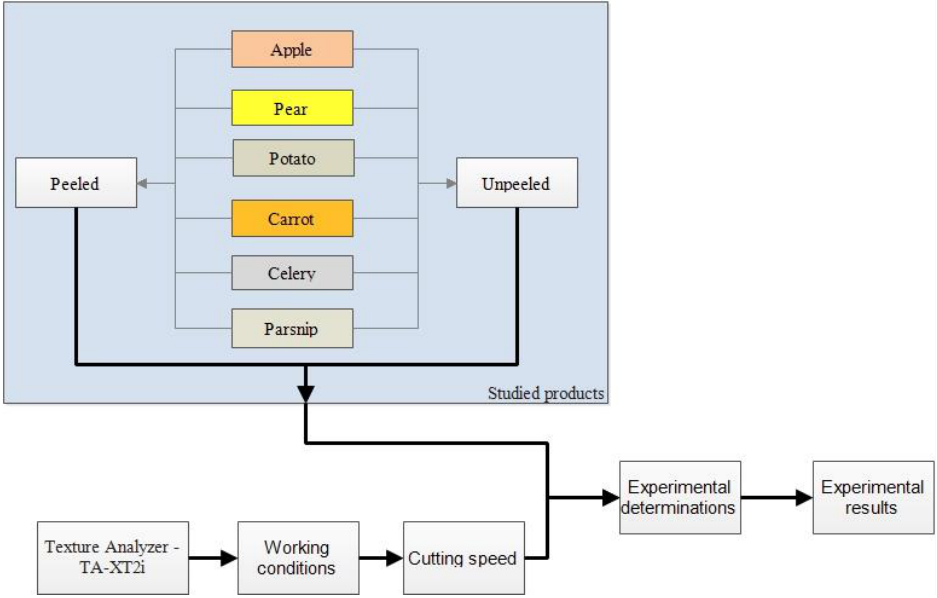
Figure 2. For experimental determinations, there is a working methodology.